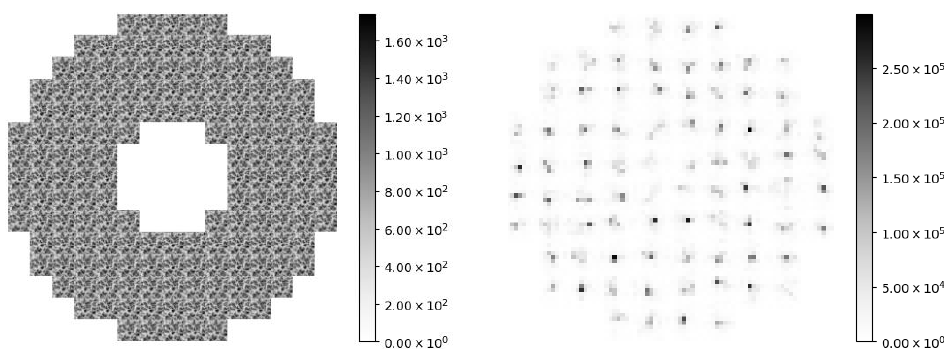
Figure 2. Information received by the SHWFS in diurnal observation on the left and in night-time observations on the right. In solar observations, due to the source’s proximity, an extended image is received by each subaperture of the SHWFS, saturating all the pixels instead of blurred spots as happens in the night scenario, meaning that the algorithms used in night AO have to be modified in diurnal AO.